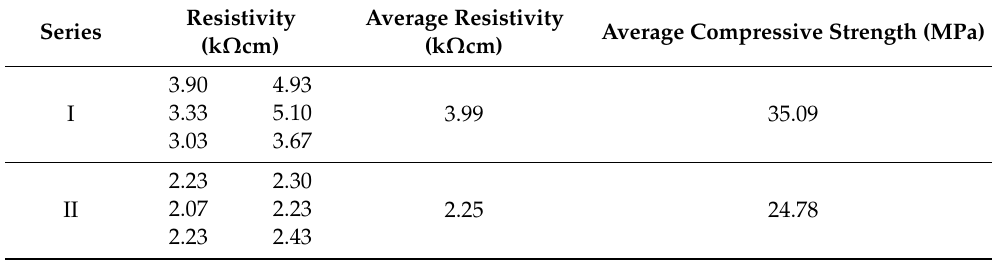
Table 6. Resistivity test of geopolymer concrete beams.